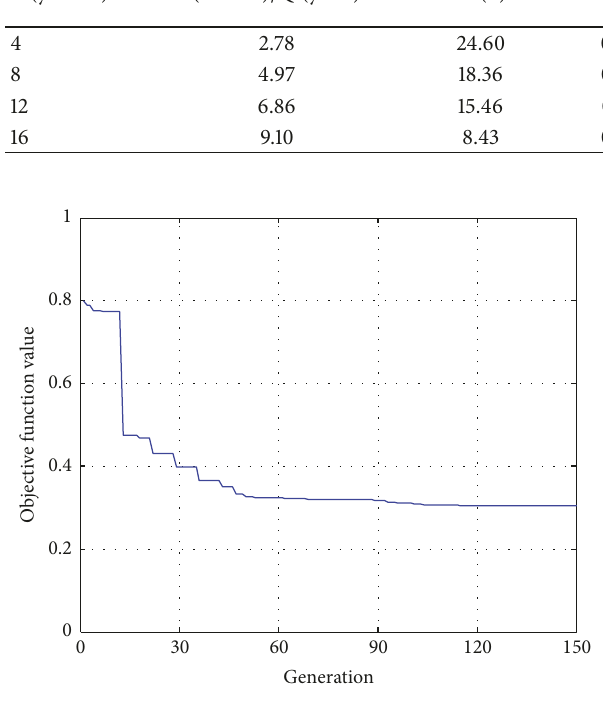
Figure 5: Optimization process of